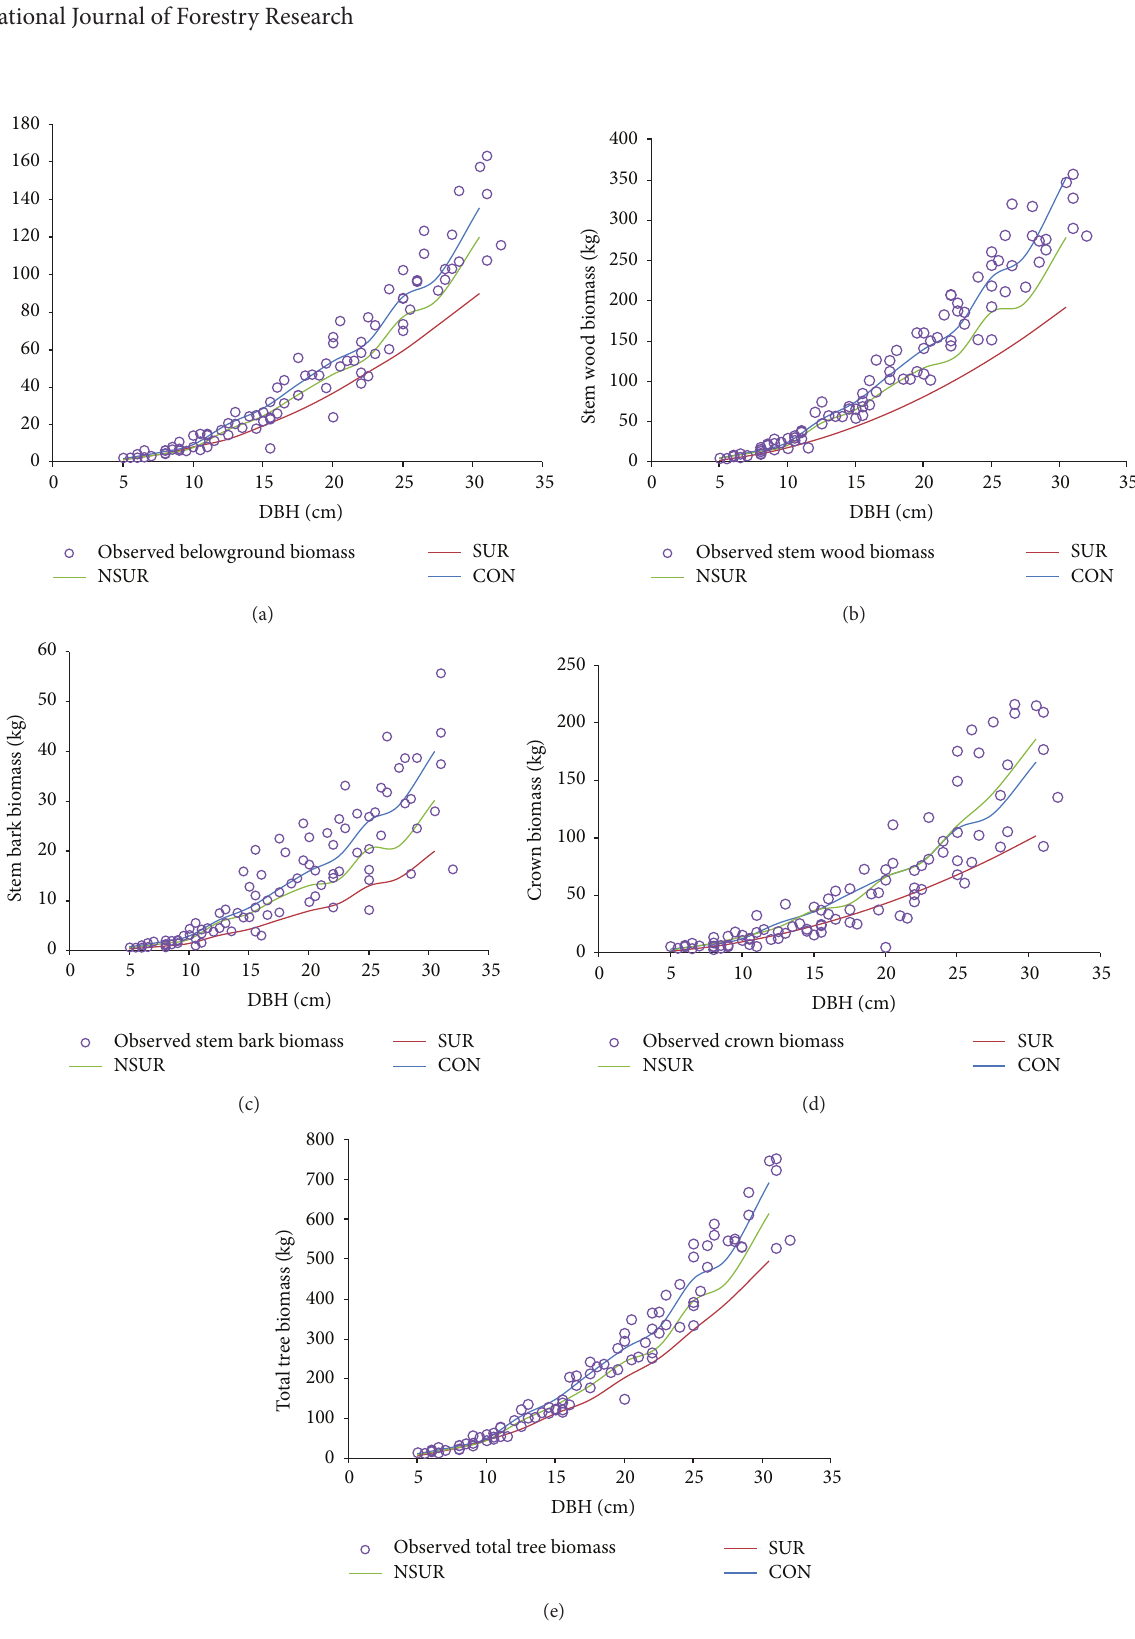
Figure 5: Observed biomass versus DBH values and regression lines obtained from the different methods of achieving additivity for (a) belowground, (b) stem wood, (c) stem bark, (d) crown, and (e) total tree